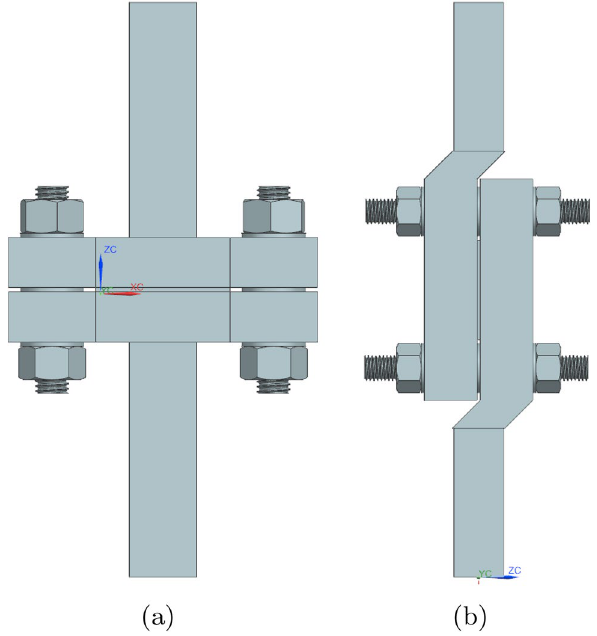
Fig. 2 An illustration of the test fixture used for subjecting the micro-sandwich to a transverse tension and b out-of-plane shear, as presented in [21]. The nuts and washers, used during mounting of the Hybrix™ specimens, were removed before